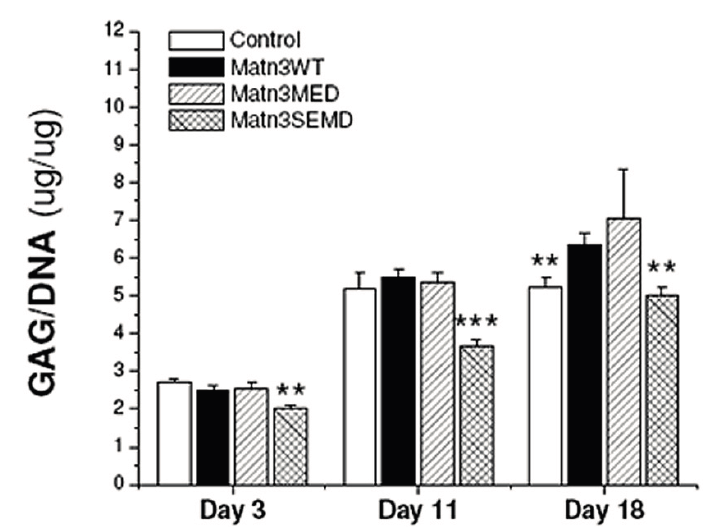
Figure 7. SEMD MATN3 transfected primary synovium derived mesenchymal stem cells exhibit reduced GAG content. GAG content was measured using a dimethylmethylene blue assay and values were normalized to DNA content. Controls are cells transfected with empty vector. ** p ≤ 0.01, *** p ≤ 0.005 vs. WT MATN3 transfected